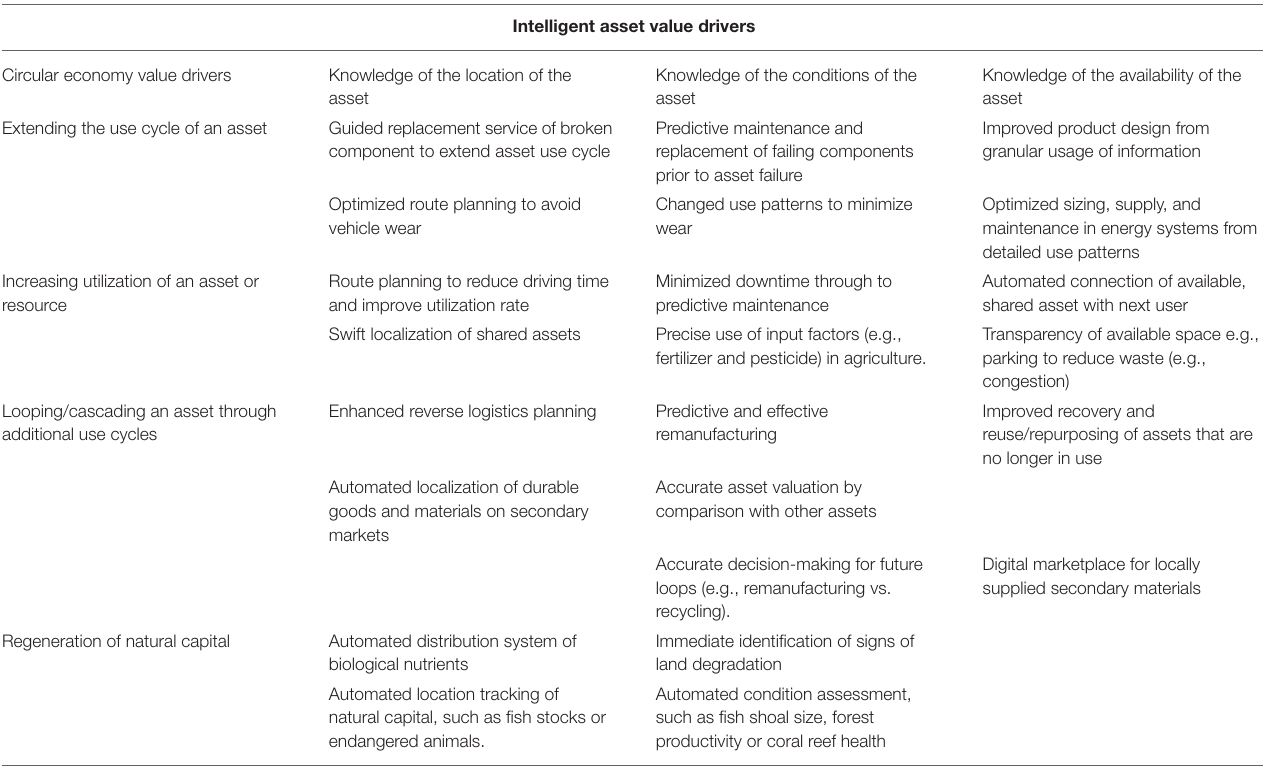
TABLE 1 | Intelligent asset value drivers for